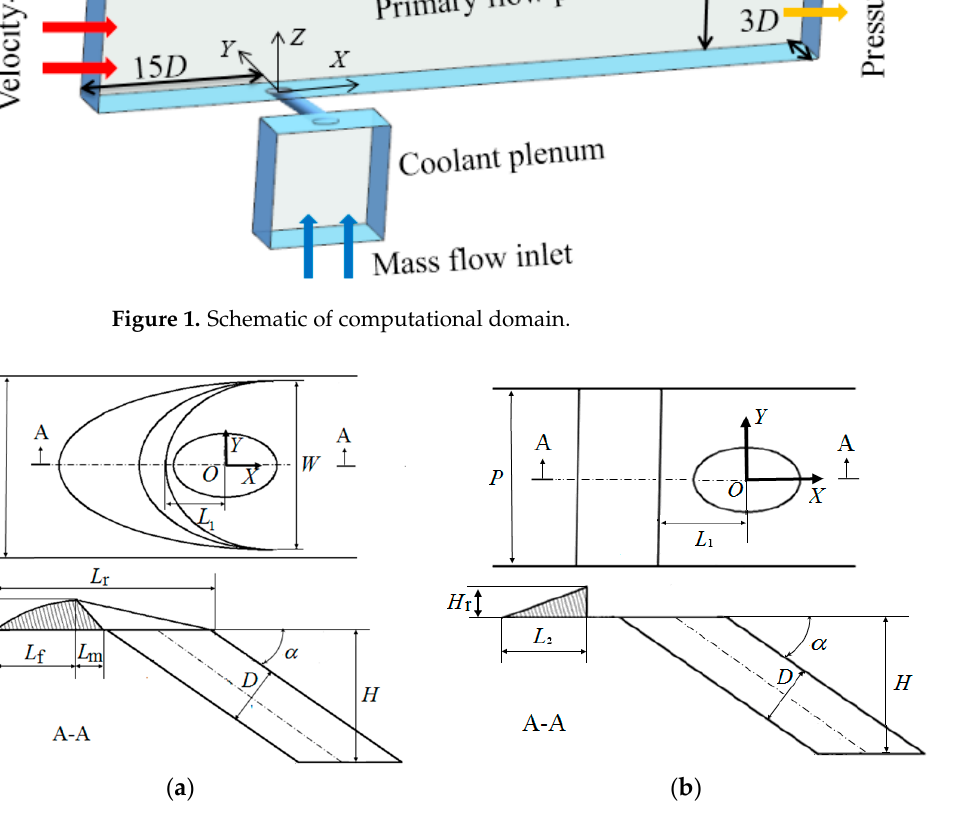
Figure 2. Schematic diagram of upstream ramps: ( a ) detailed parameters of SDR; ( b ) detailed parameters of SWR. Table 1. Main geometric